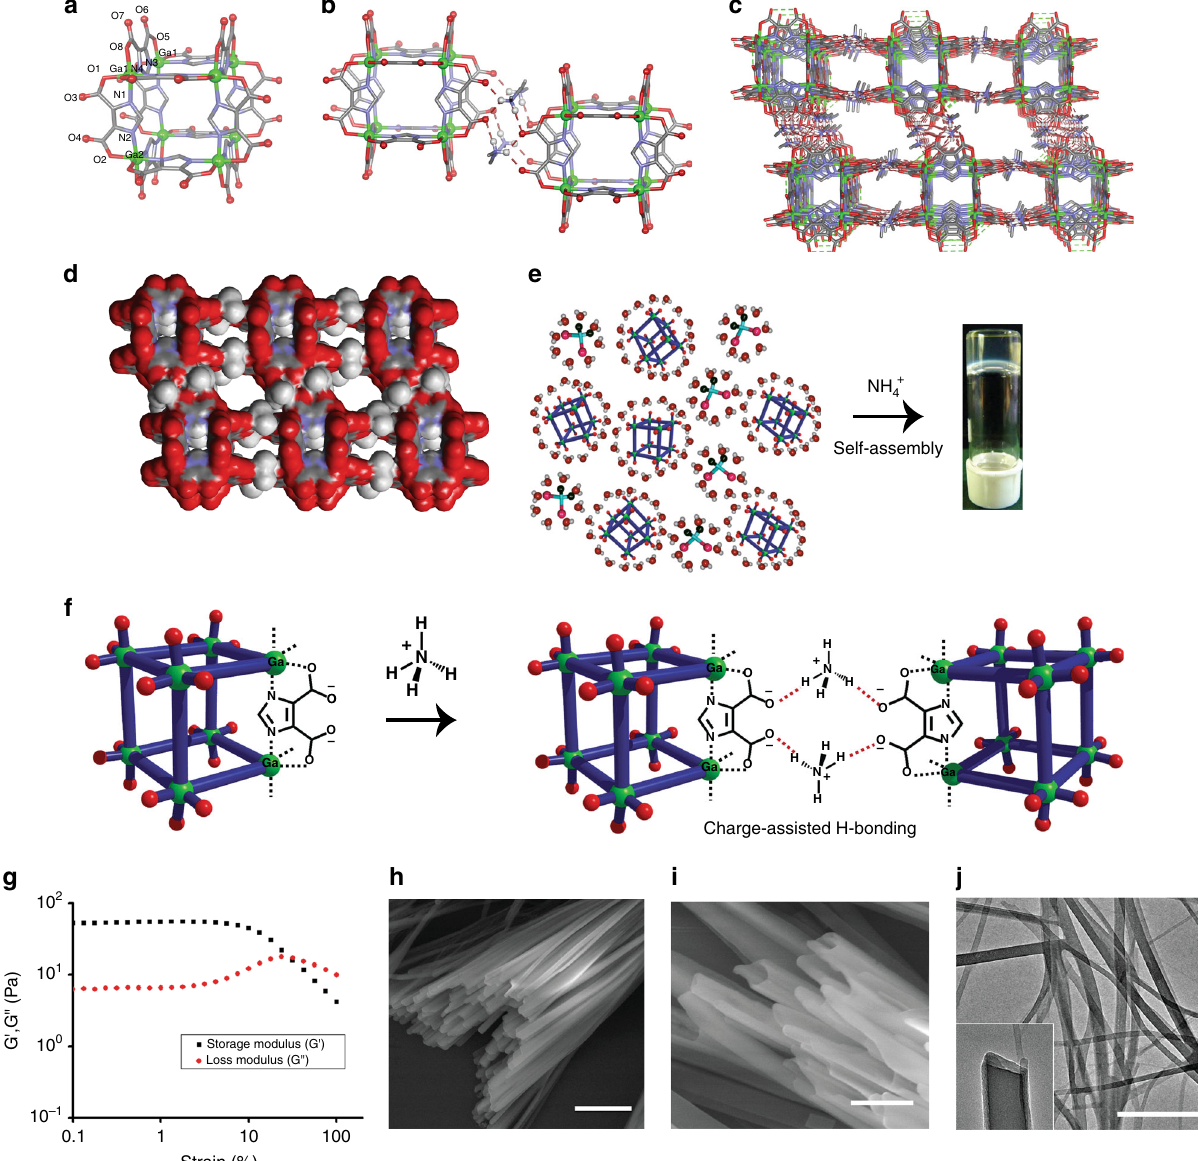
Fig. 2 Crystal structure of 1 and self-assembly of MOC with NH 4 + binder. a Structure of (Ga 8 (ImDC) 12 ) 12 − cube ( MOC ). b Two MOC s are connected to each other via intermolecular H-bonding with four DMA cations. c 3D supramolecular packing of the MOC s in 1 , where each cube is connected to six neighbouring cubes through DMA cations. d Space fi lling structure of 1 showing the window of the 3D channels. e Formation of MOC - G1 hydrogel from aq. solution of MOC s in presence of NH 4 + binder. f Schematic showing self-assembly of MOC with NH 4 + binder through charge-assisted H-bonding interaction. g Oscillatory strain measurements (frequency = 1.0 rad/s) of MOC - G1 , the squares (black) and circles (red) indicate storage ( G ′ ) and loss modulus ( G ′′ ), respectively. h , i FESEM images of MOC - G1 xerogel showing the formation of nanotubes with rectangular cross-section, h scale bar = 2 μ m and i scale bar = 1 μ m. j TEM image of MOC - G1 xerogel showing the formation of nanotubes (scale bar = 500 nm). Inset is showing opening of the